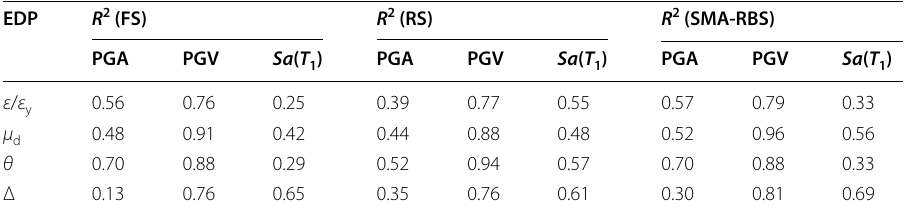
Table 3 R 2 in PSDMs for bridge